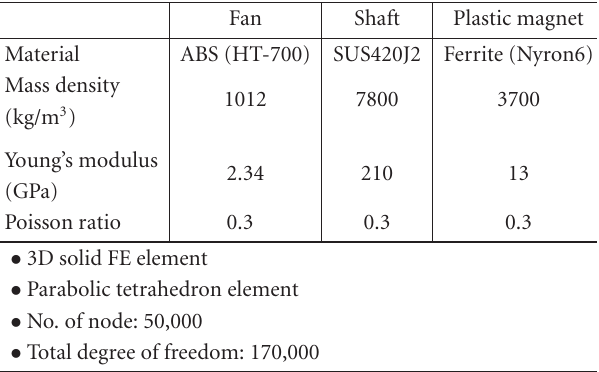
Figure 6: 3D FEA model of fan-motor shaft system.